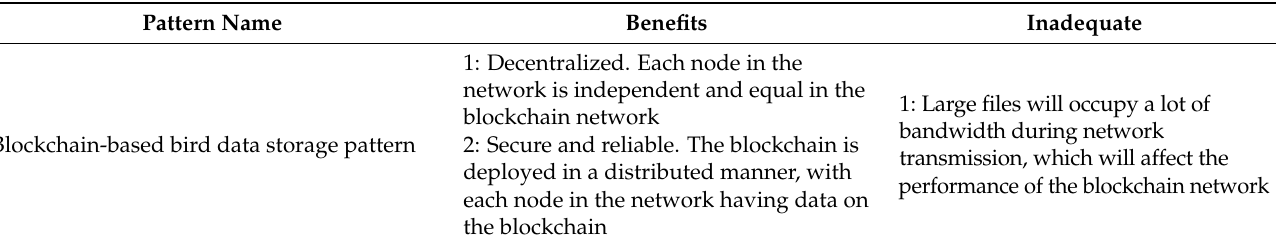
Figure 9. Schematic diagram of Dinopium data uplink based on Pattern III. Table 6. Blockchain-based bird data storage pattern characteristics table.